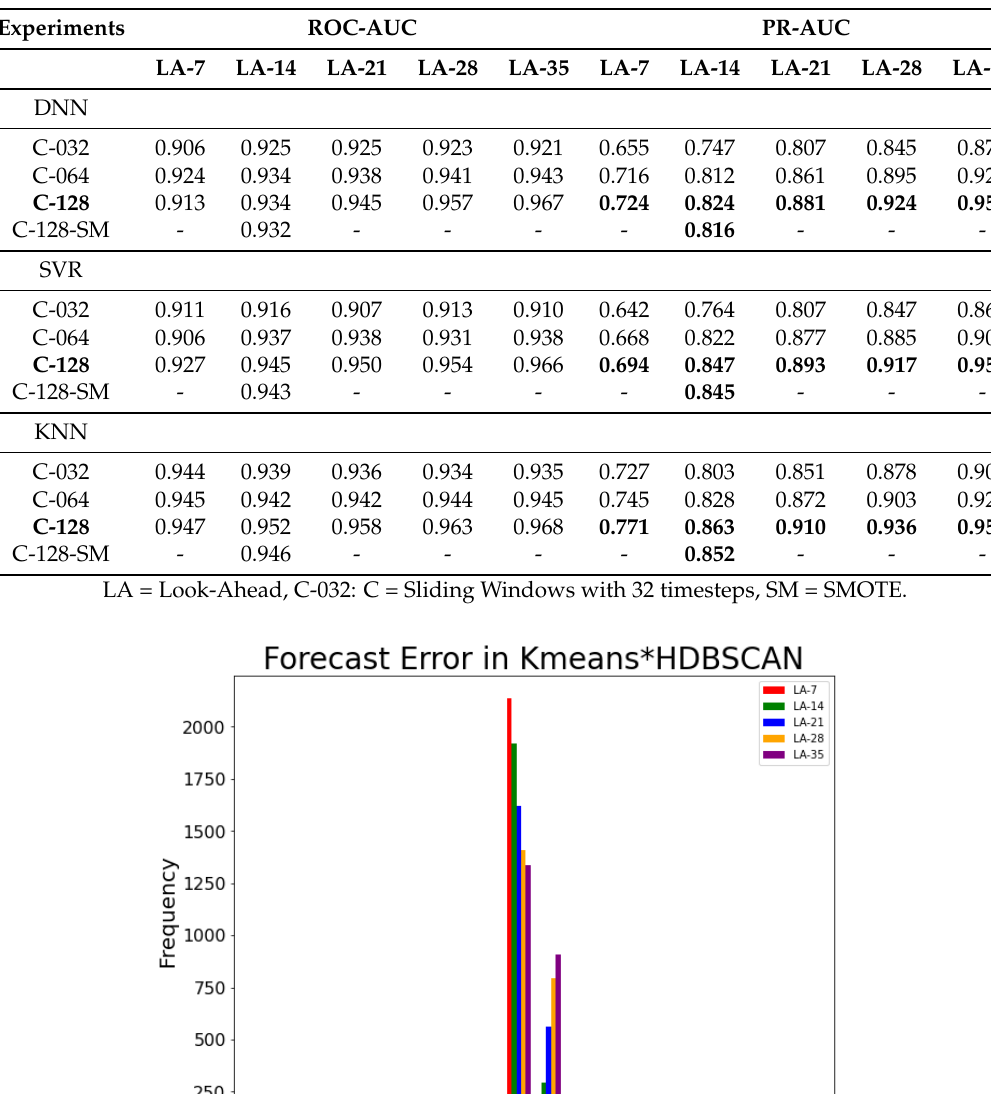
Table 10. ROC and PR of DNN, SVR, and KNN after Kmeans*HDBSCAN C0H0 in various timesteps.